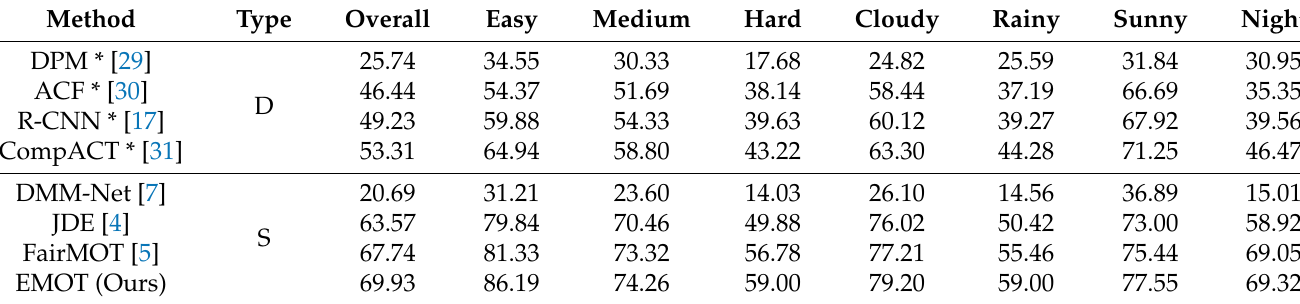
Table 2. Object detection results of our single-shot MOT system and different methods, which are evaluated on the UA-DETRAC-test set. Legends: D—detector; S—single-shot MOT system. The results of * were taken from Wen et al. [11]. Method